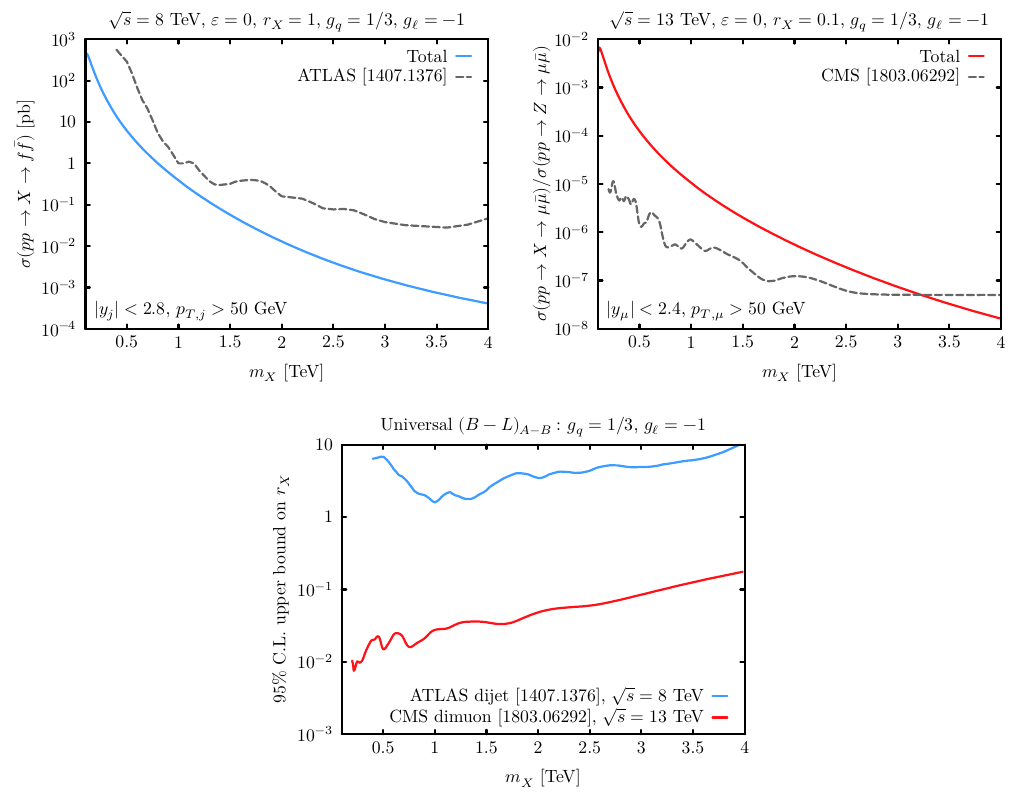
p s = 8 TeV p s = 13 TeV and the 95% C.L. limit